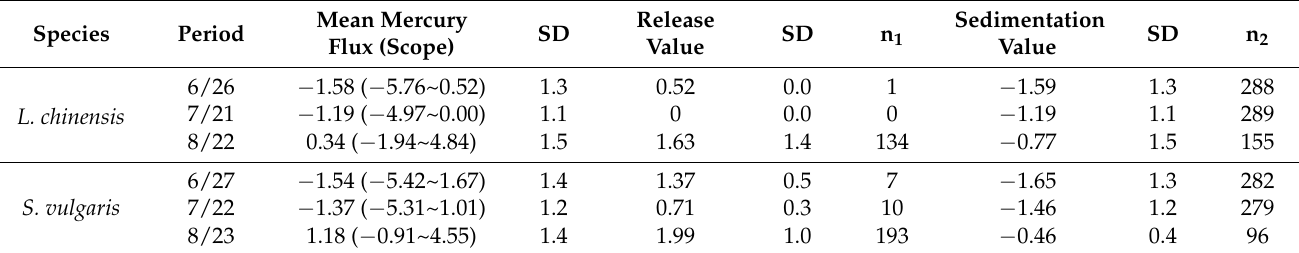
Table 3. Independent processing results of the plant and atmosphere 24-h mercury exchange and deposition release fluxes (ng · m − 2 · h − 1